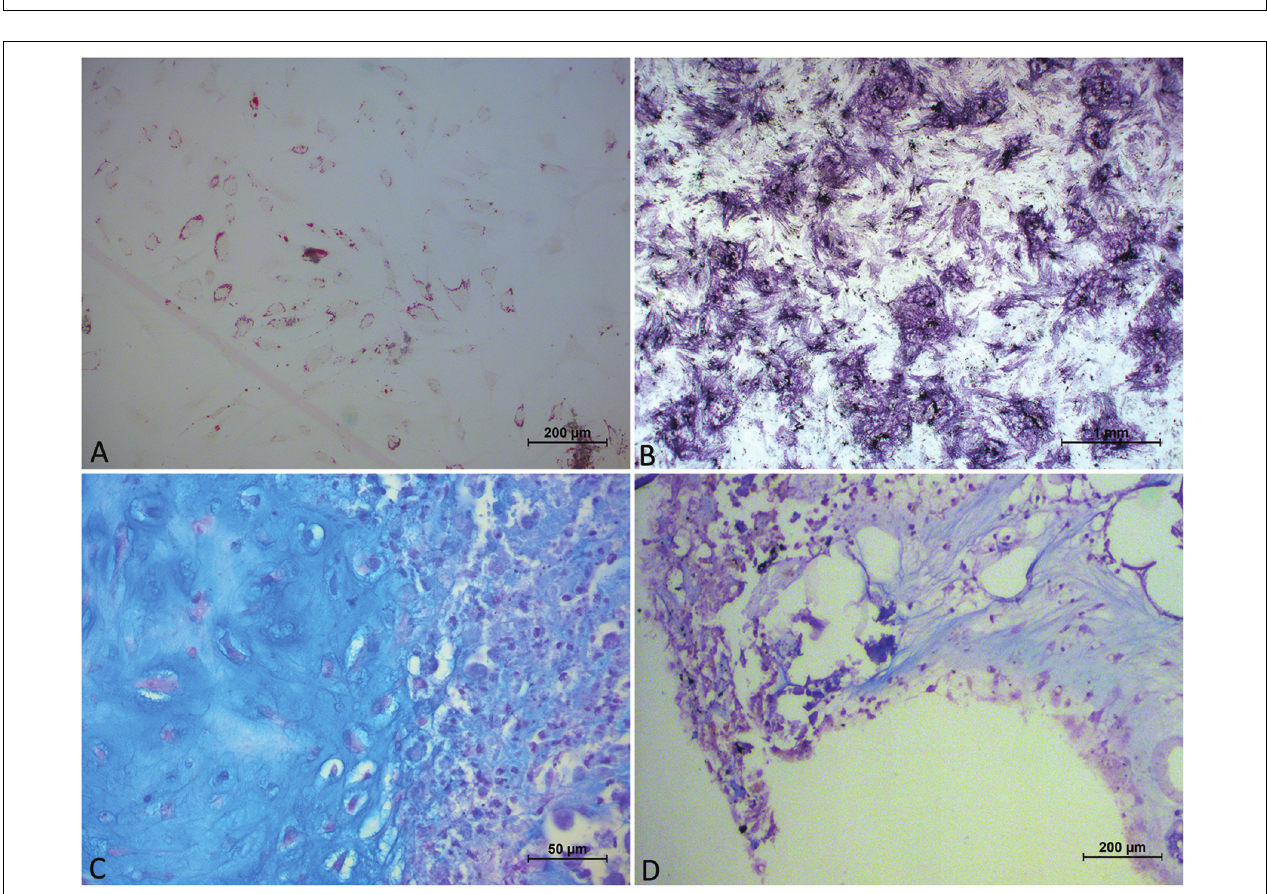
FIGURE 4 | Image showing panel (A) cells, obtained from collagenase digestion, in adipogenic medium, exhibiting the morphology of multi-vacuolar adipocytes (arrows; Scale bar: 200 µ m); (B) cells, obtained from collagenase digestion, in osteogenic medium. Formation of mineralized matrix was detected by Von Kossa staining (arrows; Scale bar: 1 mm); (C) cells, obtained from collagenase digestion, in chondrogenic medium demonstrated by Alcian Blu staining; (D) cells, obtained from Rigenera digestion, in chondrogenic medium demonstrated by Alcian Blu staining.